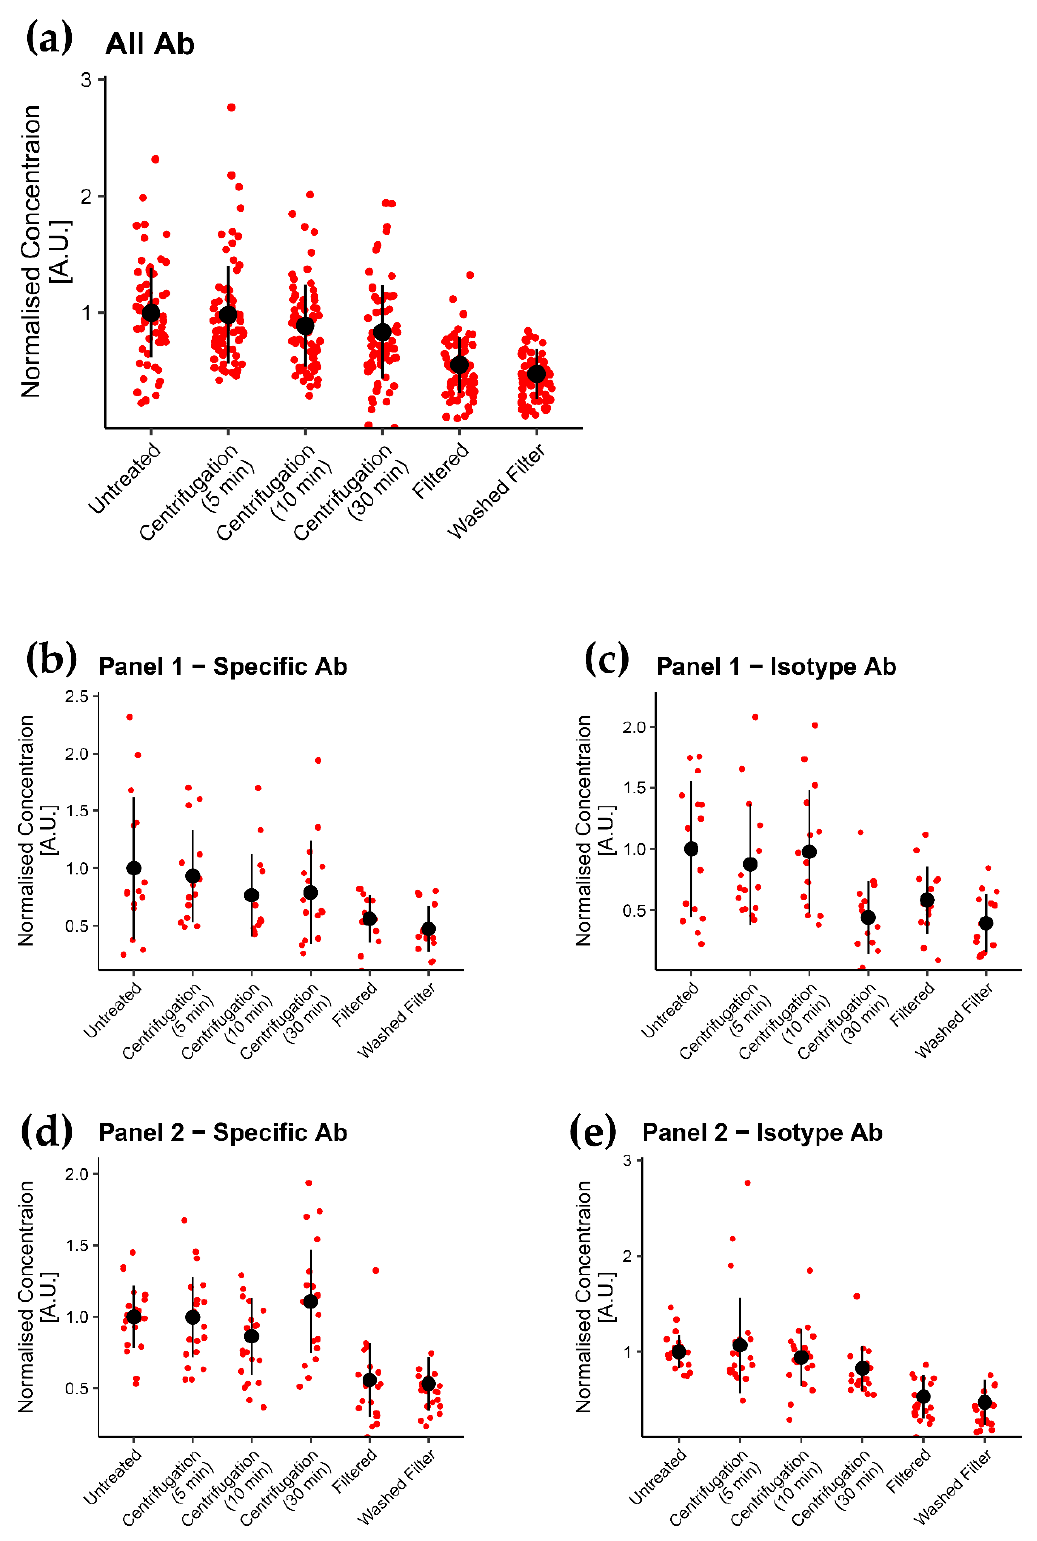
Figure 3. ( a ): Distribution of concentrations of all labels for each treatment when normalized to the average of all untreated labels. ( b – e ): distribution of concentrations of all labels for P1-specific, P1-isotype, P2-specific, and P2-isotype label, respectively, for each treatment when normalized to the average of all untreated labels.